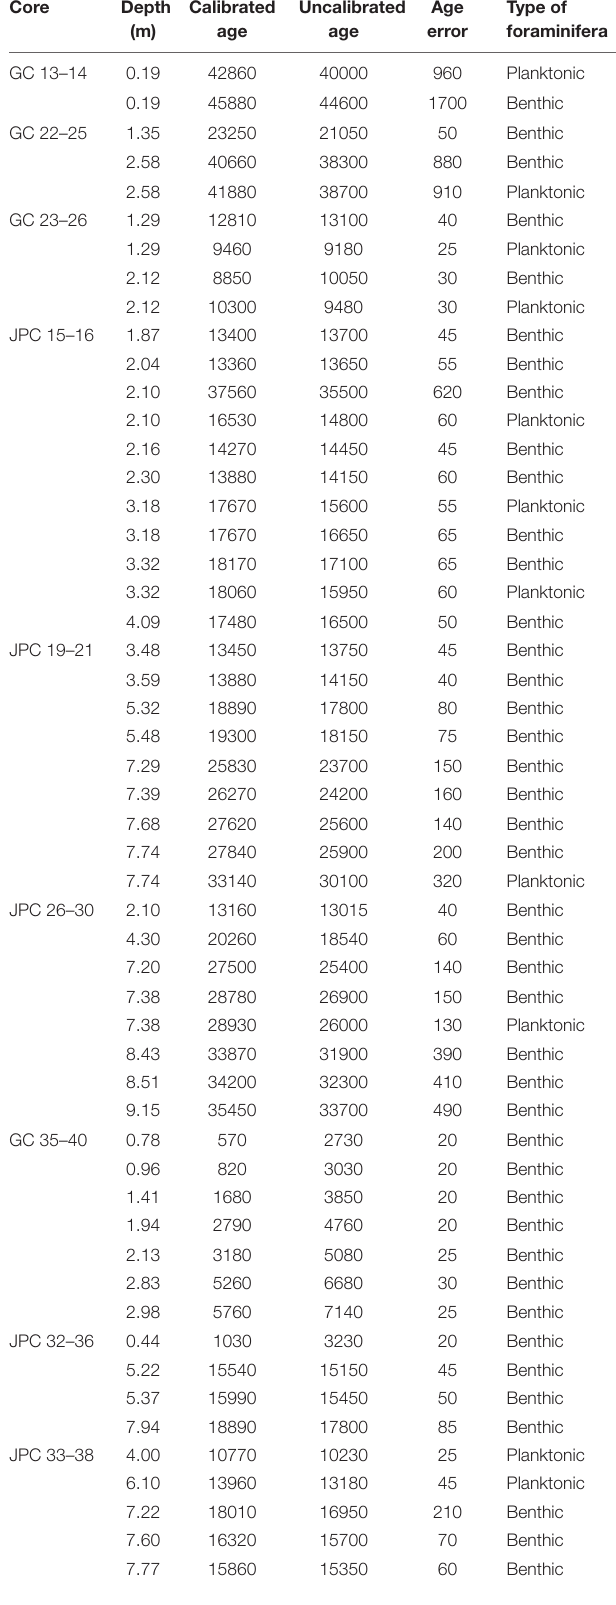
TABLE 1 | Radiocarbon ages used in this